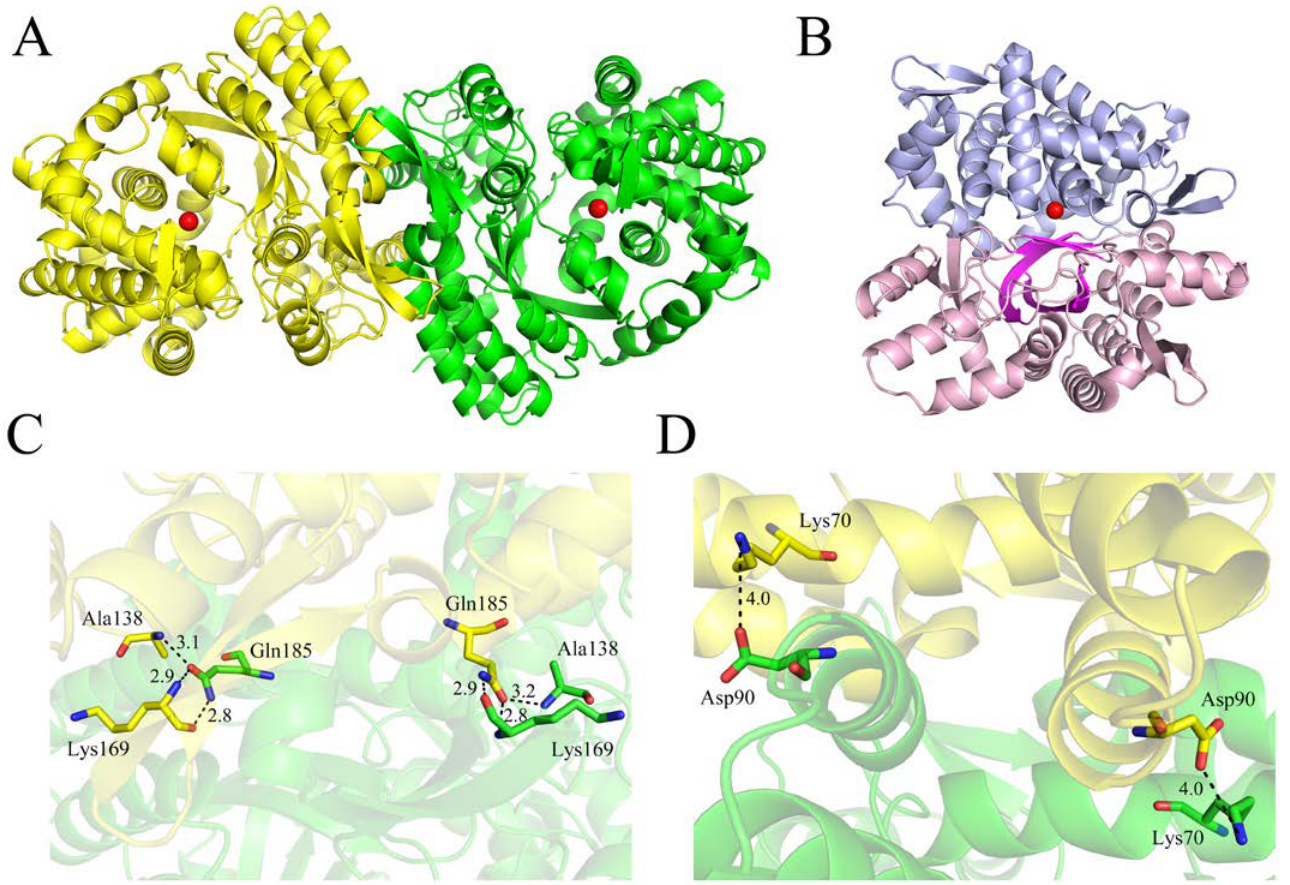
Figure 5. Overview of the structure of Co DPP III. ( A ) Ribbon representation of the functional dimer of Co DPP III. The two monomers are shown in yellow and green. ( B ) Ribbon representation of Co DPP III monomer. The upper and lower domains are shown in light blue and pink, respectively. The five-stranded β -structure is shown in magenta. The catalytic zinc ion is represented by a red sphere. ( C ) Close-up view of the hydrogen bonds formed in the interface. ( D ) Close-up view of the salt bridges formed in the interface.